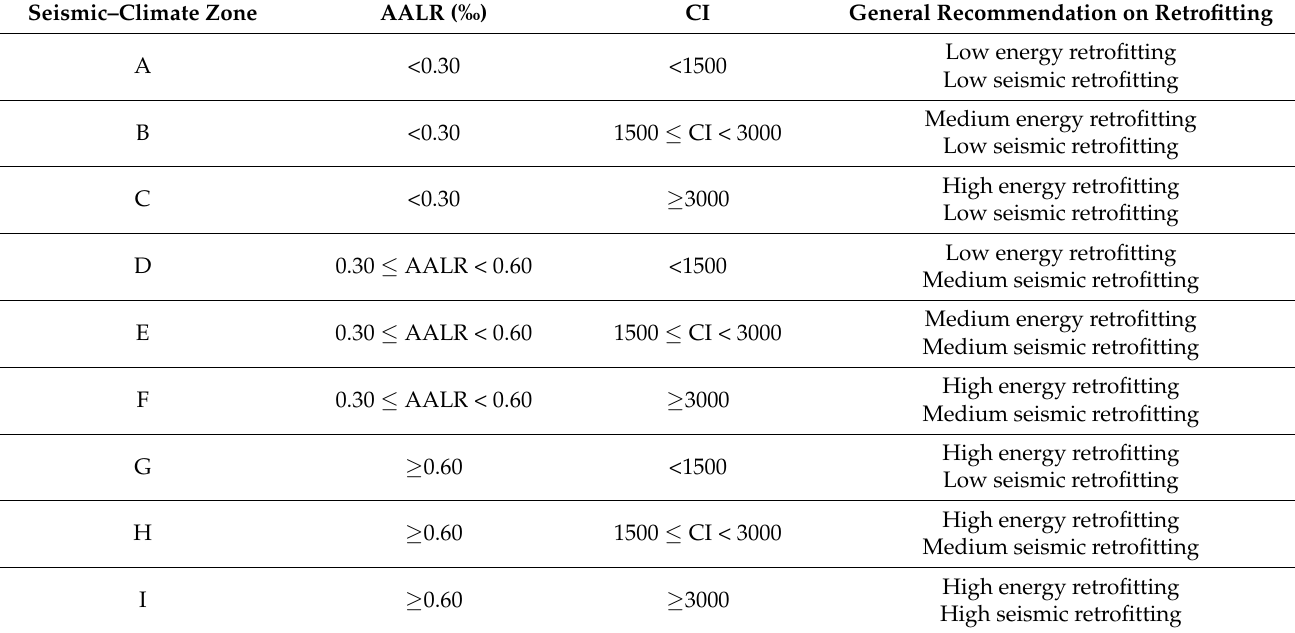
Table 1. Definition of seismic–climate zones (SCZ).